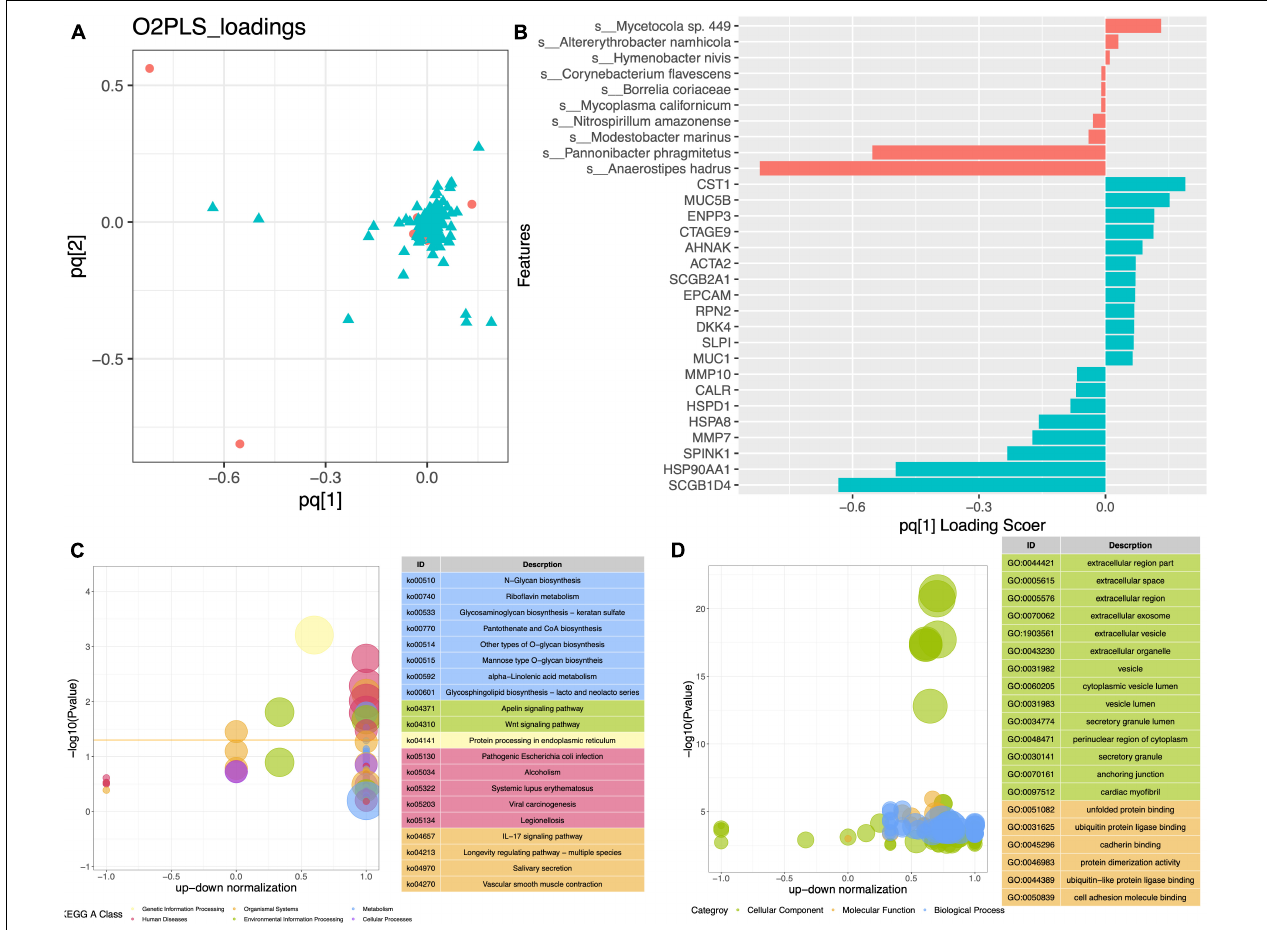
FIGURE 3 | Integrated analysis of interactions between the host and microbiota. (A) Loading plot of O2PLS model between differentially abundance species and differentially expression genes. (B) Top 10 loading species and top 20 loading genes. KEGG (C) and GO (D) enrichment analysis of top 50 loading genes.